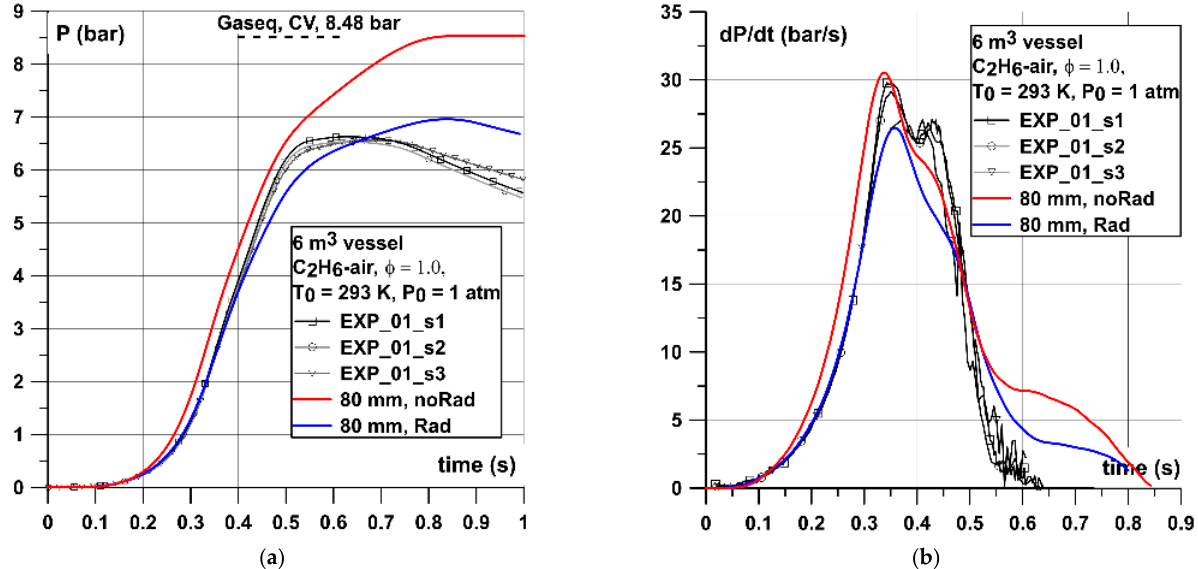
Figure 14. ( a ) Pressure and ( b ) dP/dt graphs for stoichiometric C 2 H 6 –air mixture in the 6 m 3 vessel.